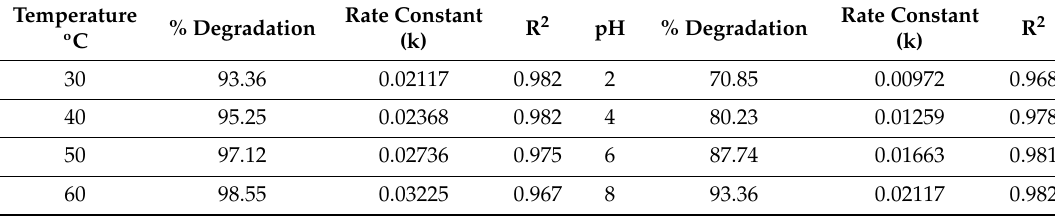
Table 1. E ff ect of temperature and pH on the degradation e ffi ciency (%) and rate constant. Temperature